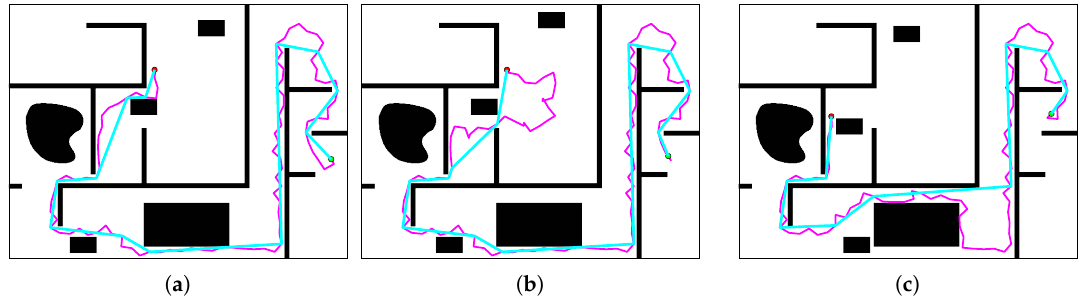
Figure 18. The results of 3 steps in one experiment of the proposed method. ( a ) the 9th step. ( b ) the 10th step. ( c ) the 15th